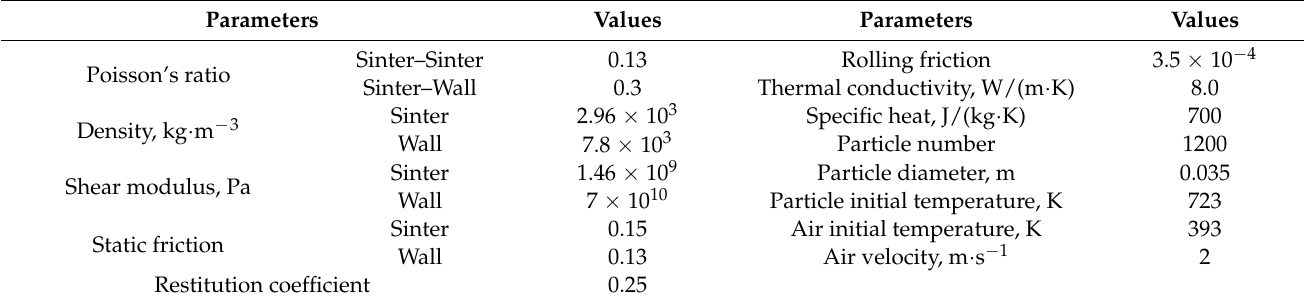
Table 1. Material properties and simulation parameters. Table 2. Operating